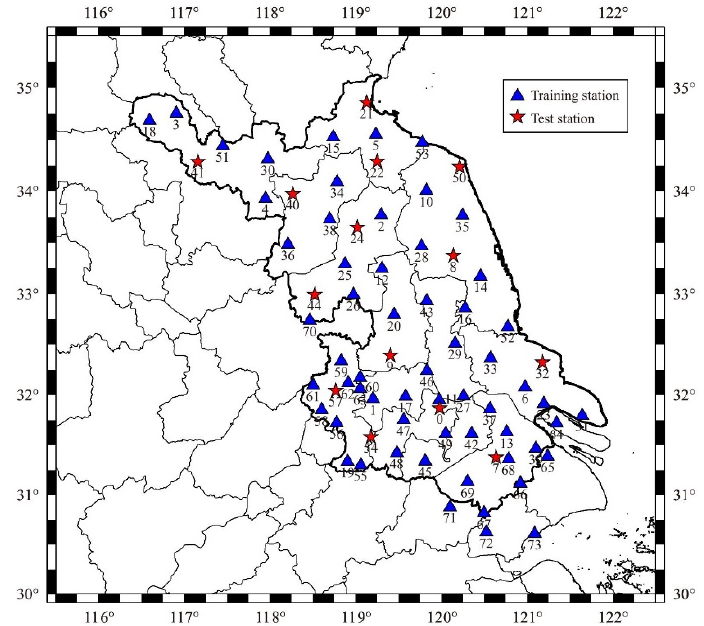
Figure 3. The distribution of JSCORS.